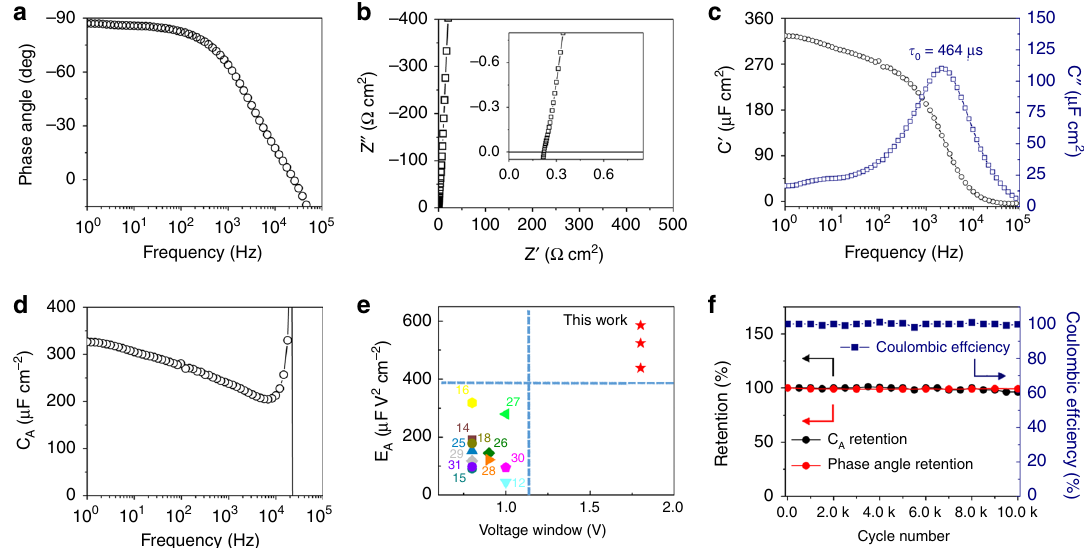
Fig. 3 The electrochemical performances of unit. a Plots of phase angle versus frequency. b Nyquist plot; inset: the expanded view at high frequencies. c Plots of the real or imaginary part of speci fi c capacitance (C ′ or C ″ ) versus frequency. d Plots of areal speci fi c capacitance ( C A ) as a function of frequency. e Comparison of E A and voltage window of the aqueous hybrid electrochemical capacitor (AHEC) with those of the reported aqueous AC-line fi ltering electrochemical capacitors (ECs) (Supplementary Table 1) 12,14 – 16,18,25 – 31 . f Cycling stability and the Coulombic ef fi ciency of the AHECs at a current density of 5 mA cm − 2 for 10,000 cycles. Source data are provided as a Source Data fi (GCD) curves with a triangular shape also con fi rm the ideal capacitive behavior of the AHEC (Supplementary Fig. 11).